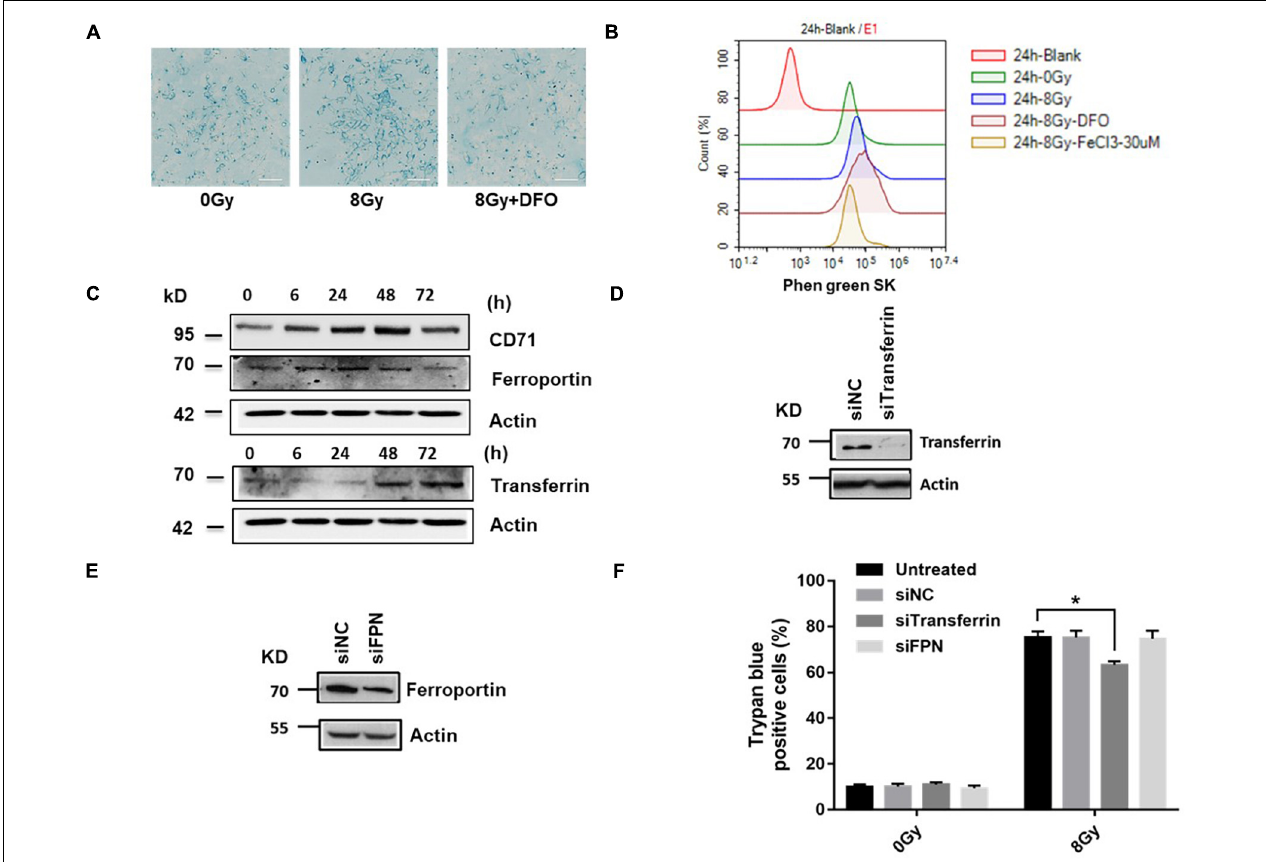
FIGURE 2 | Radiation increased iron level and ROS generation in MDA-MB-231 breast cancer cells. Cells were pretreated with DFO, followed by 8 Gy radiation, Prussian blue staining for intracellular iron was performed (A) . Cells were pretreated with DFO or FeCl3 before 8 Gy radiation. Intracellular chelatable iron was detected using the fluorescent indicator Phen green SK with Flow cytometry (B) . The expressions of iron-related proteins Transferrin (Tf), Transferrin receptor (CD71), and Ferroportin (FPN) were performed after 8 Gy treatment (C) . Knockdown of Transferrin, FPN by siRNA as demonstrated by western blot (D,E) . Cells were transfected with control siRNA (siNC) and siRNA against Transferrin (si Tf), Ferroprotein (siFPN) for 48 h, the amount of cell death was determined at 48 h after 8 Gy radiation (F) . These results were representative of three independent experiments and expressed as means ± SD. P -values were calculated using repeated measure ANOVA with P < 0.05 being considered as statistical significance, * P <